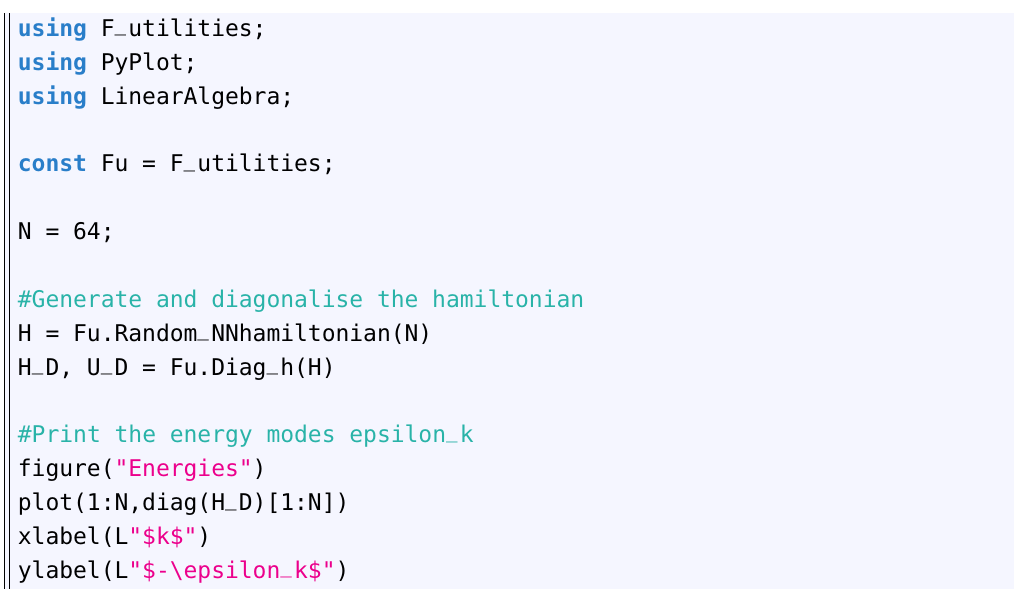
Computing the entanglement contour of a partition of a ground state In this